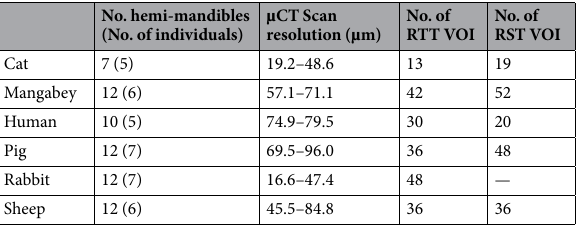
Table 3. The number of hemi-mandibles analysed per species, and the total number of RTT and RST VOI used in analysis of the trabecular architecture. The hemi-mandibles were scanned using a range of resolutions, which were subject to a sensitivity test to ensure that they did not affect the histomorphometric analyses of the trabecular bone. Note that no RST VOI was calculated for the rabbit as post-canine rabbit teeth are